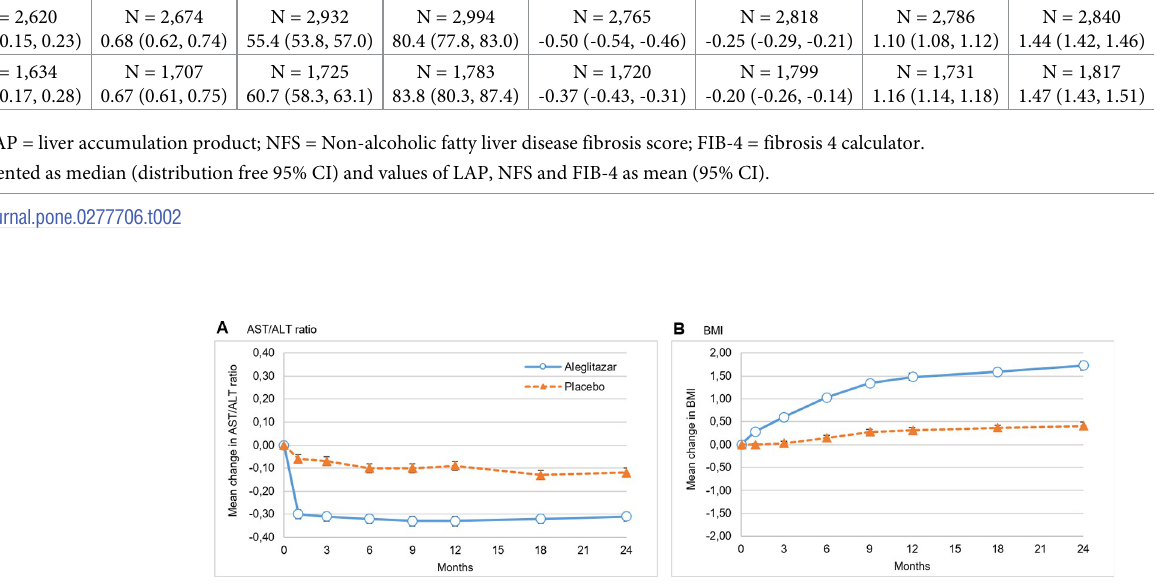
Fig 2. Change in AST/ALT ratio and BMI from baseline. Value at baseline for A: Mean AST/ALT of 1.21 for placebo and 1.22 for aleglitazar, B: Mean BMI of 29.5 kg/m2 for placebo and 29.3 kg/m2 for aleglitazar. Error bars indicate 95% CIs. Change from baseline is significantly different in the aleglitazar and the placebo group at all timepoints � 1 month for both AST/ALT ratio and BMI (all P < 0.001).